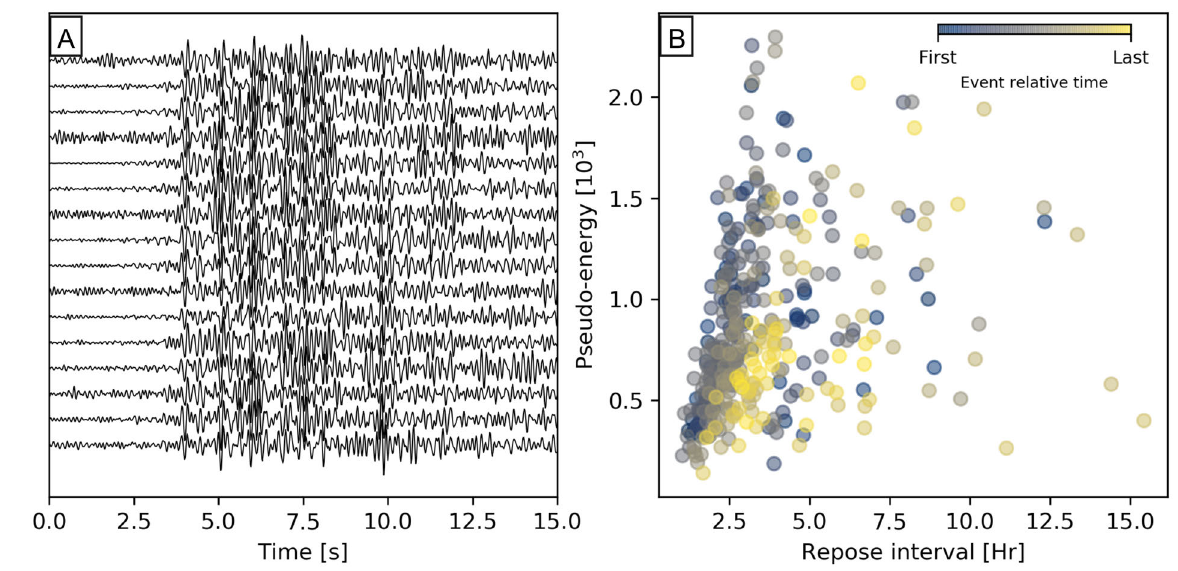
Figure 3: [A] Waveforms of the first 15 events in Family 1, as recorded at station GEO. Each waveform is normal- ized to their maximum amplitude, and plotted in order of their occurrence from the top. [B] Repose intervals versus pseudo-energy for each event in Family 1, colored by their relative age within the family duration, using waveforms recorded at station